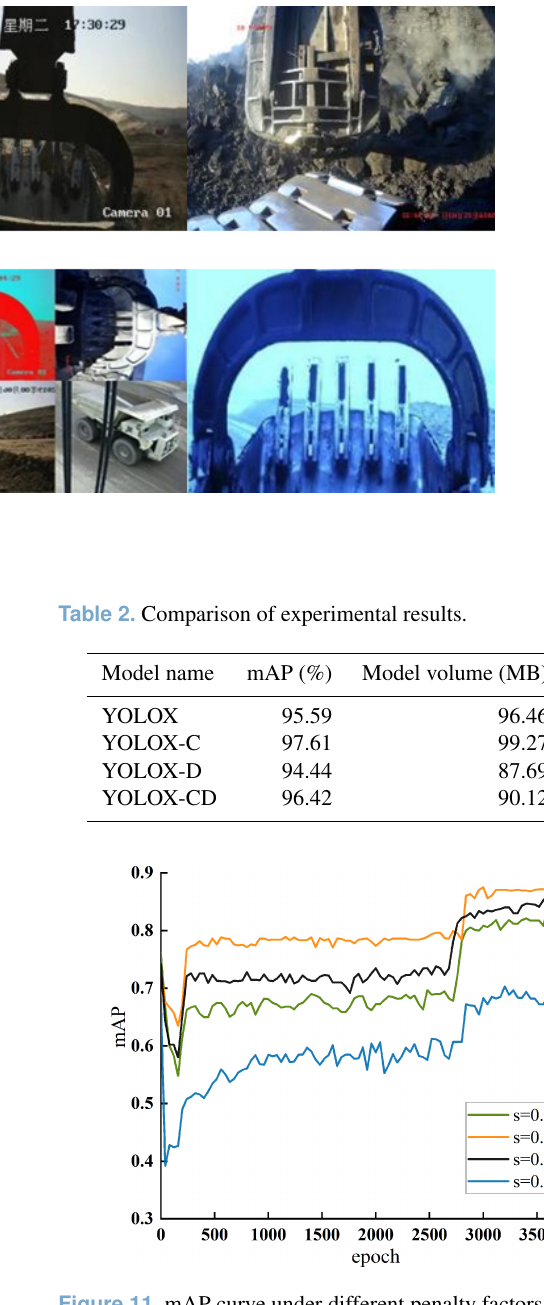
Figure 11. mAP curve under different penalty